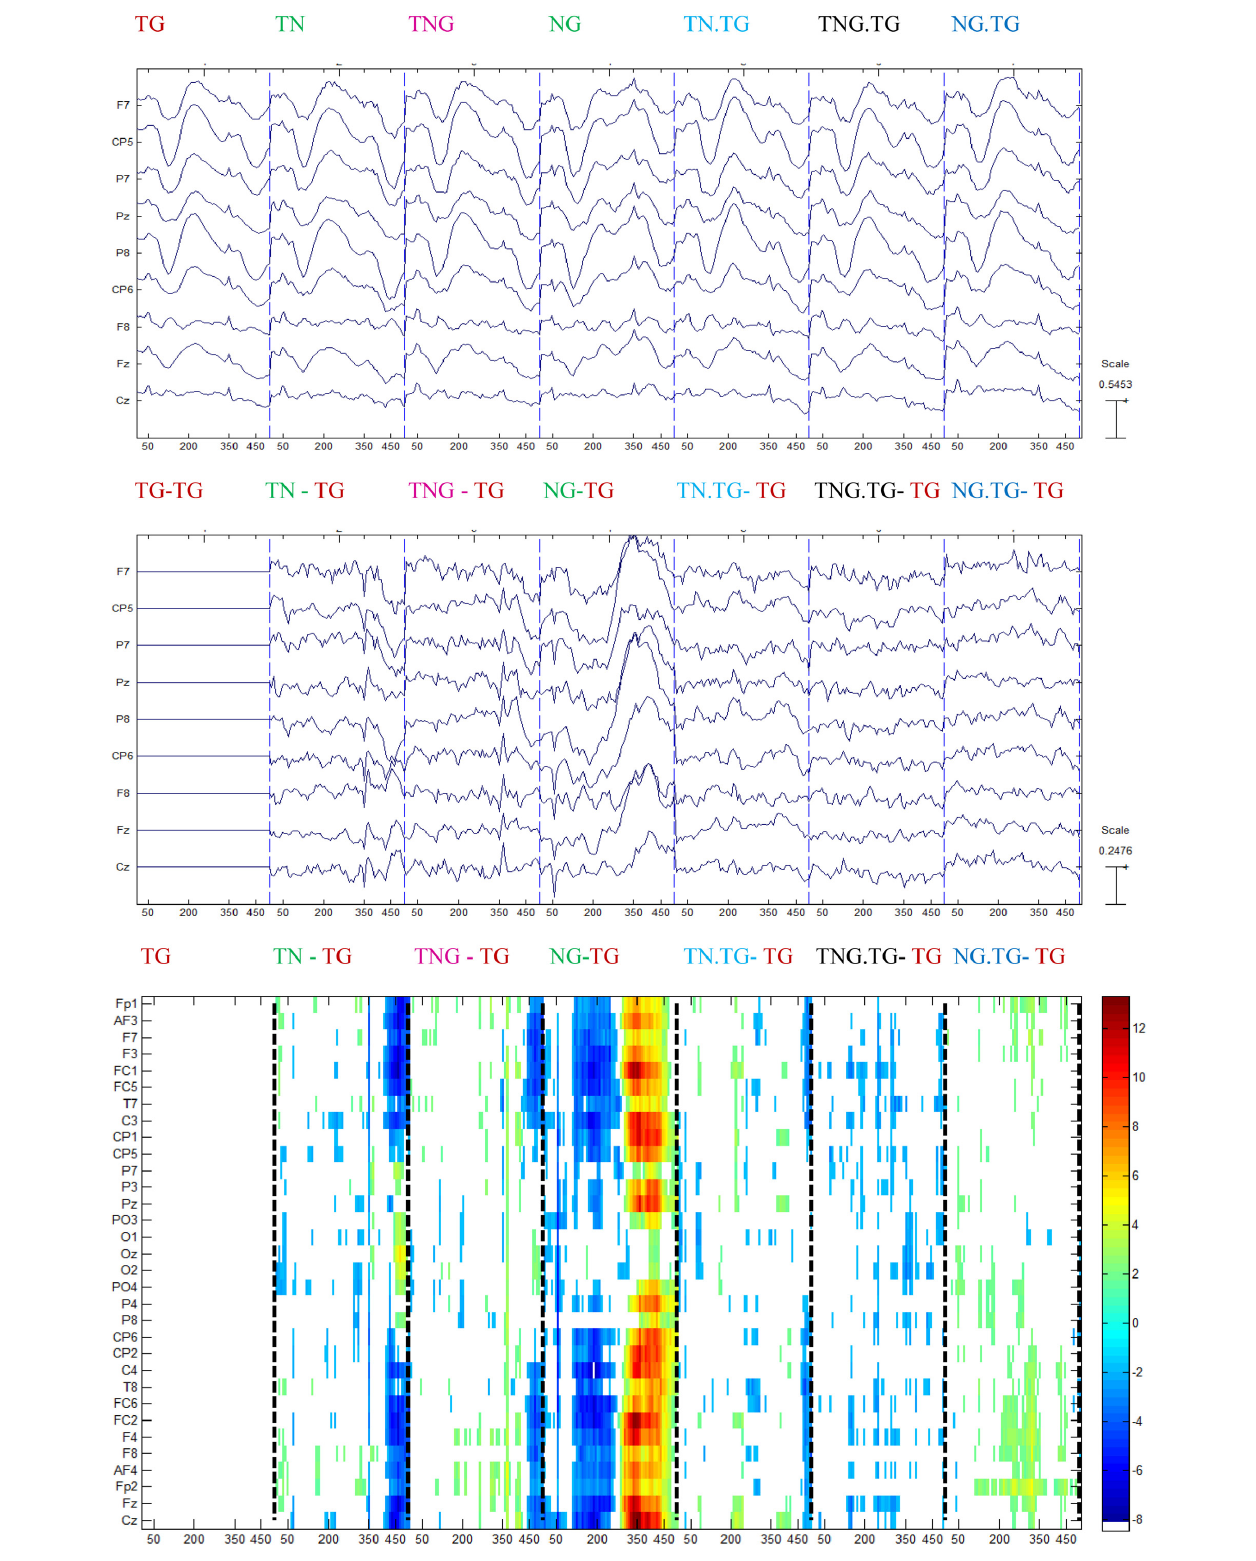
FIGURE 8 | Grand average for control group of the ERP conditions (top) subtracted from every ERP condition in the previous channels (middle), and the one-tailed t -test analysis between each condition and the standard followed by the standard ( p < 0.001) (bottom).